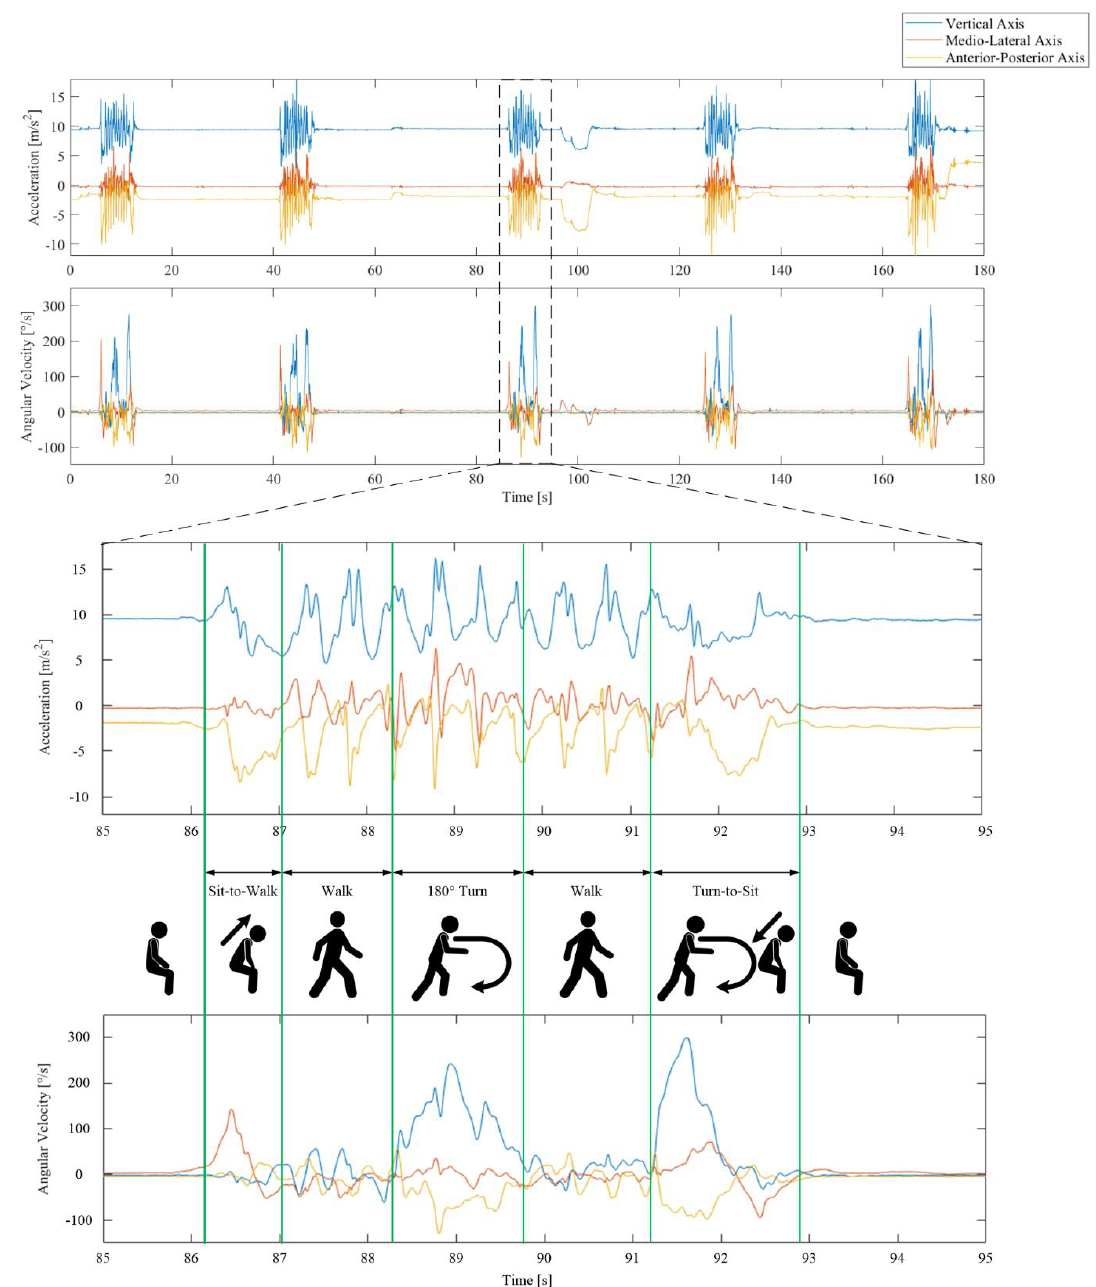
Figure 2. The 3-axis acceleration (upper) and angular velocity (lower) sensor signals recorded during five repetitions of an iTUG for one subject. The task is segmented into five phases separated by the green vertical lines.